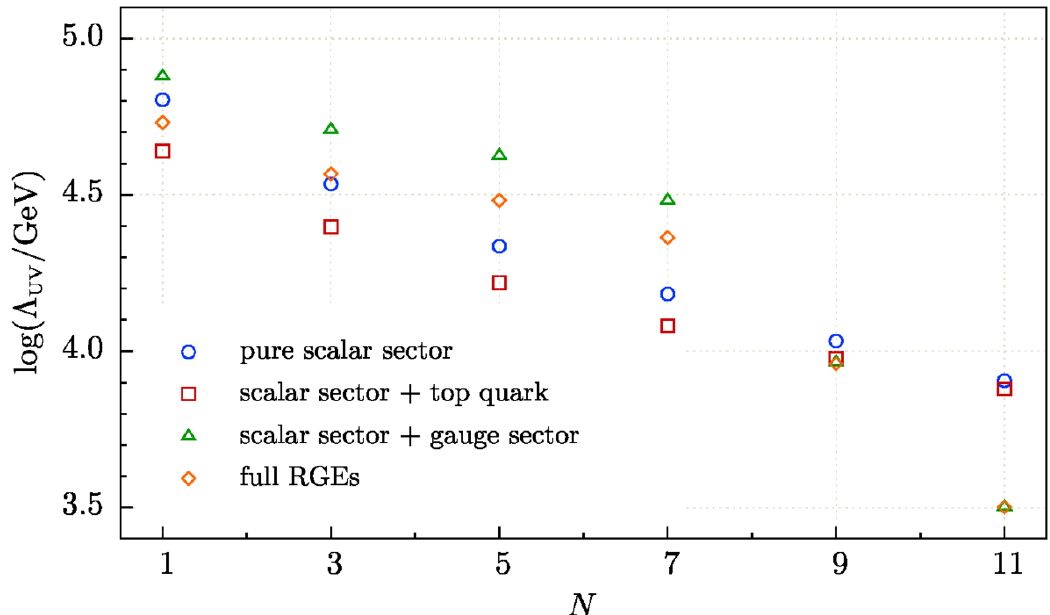
Figure 3 . Largest possible UV scale in extensions of the conformal SM by one real SU(2) L N -plet p with (cid:12)nite vev v (cid:31) < 2 v (cid:30) . The color code indicates which set of beta functions and couplings are taken into